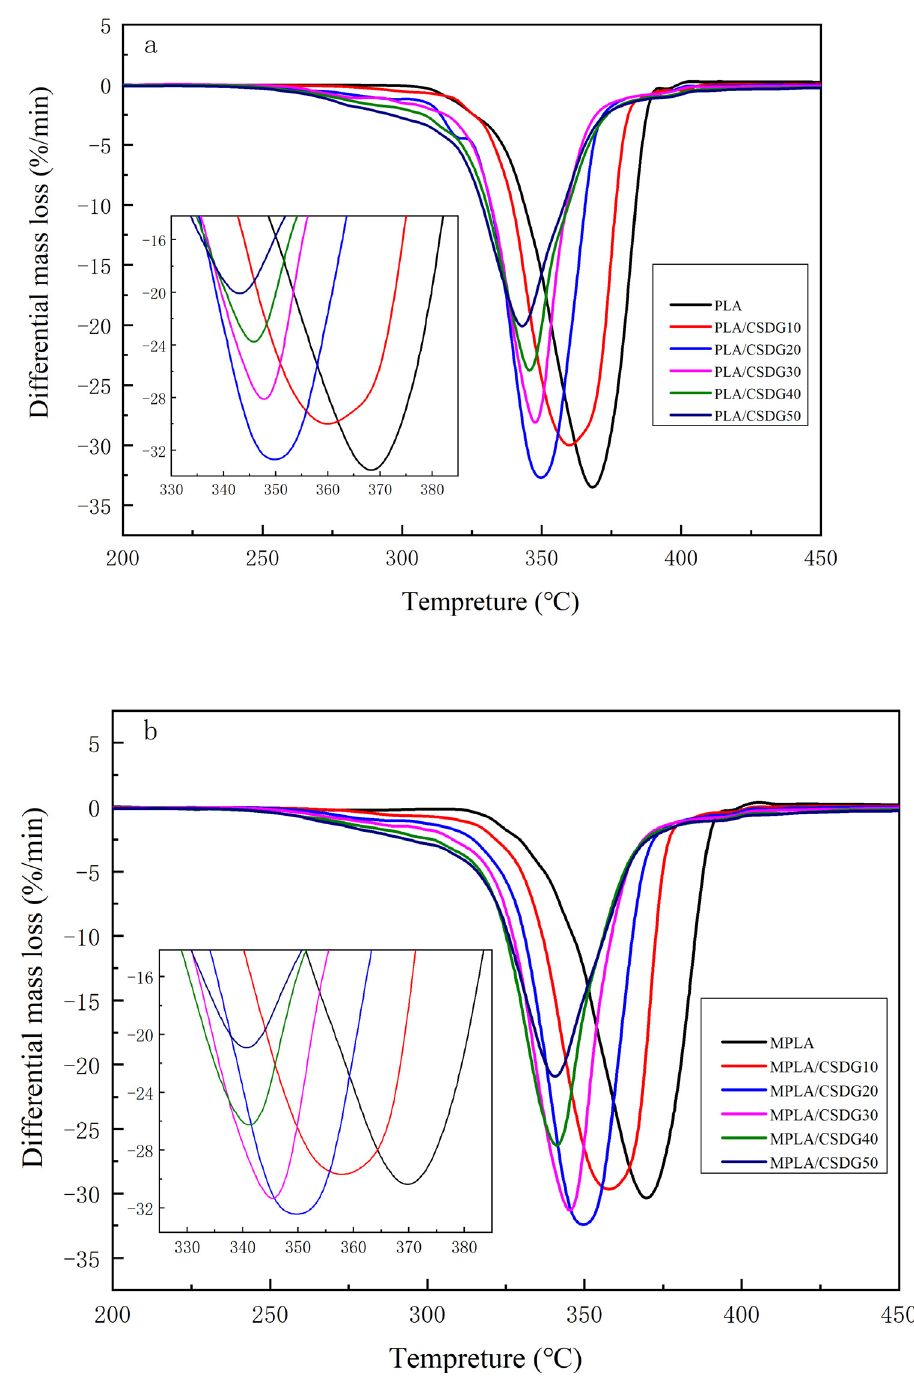
Figure 8. Differential thermogravimetric curves: ( a ) PLA/CSDG; ( b ) MPLA/CSDG.